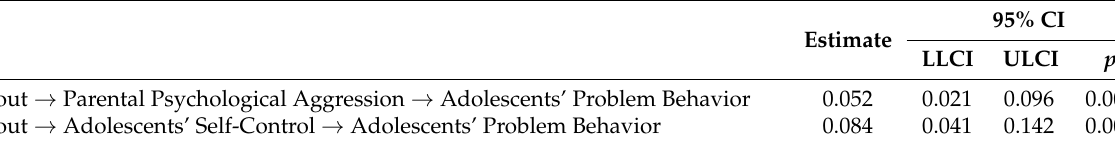
Figure 7. Standardization path model. * p < 0.05, ** p < 0.01, *** p < 0.001. Table 4. Detailed results of the bootstrapping